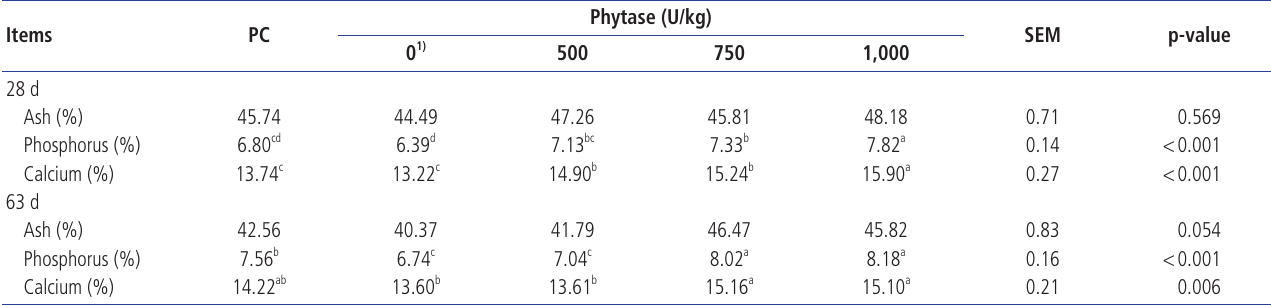
Table 3. Effect of phytase on tibia characteristics in Youxian Sheldrake